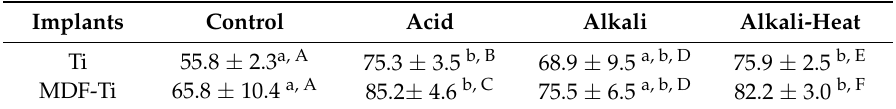
Table 5. Percentage of the measured BIC (%).